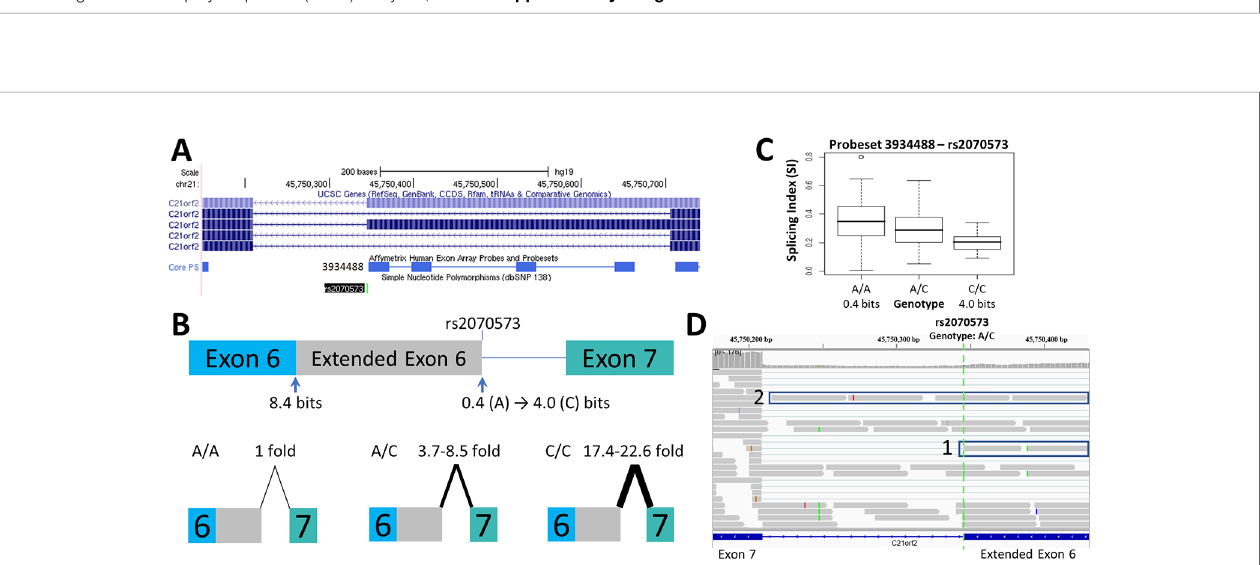
FIGURE 2 | Splicing Impact of rs2070573 ( C21orf2 ). (A) The single nucleotide polymorphisms (SNP) rs2070573 is a common polymorphism which alters the fi rst nucleotide of the extended form of C21orf2 exon 6. (B) The donor site is strengthened by the presence of the C-allele ( R i 0.4 to 4.0 bits; A > C) and its use extends the exon by 360 nt. Q-RT-PCR found a ~4-9-fold and ~17-23-fold increase in the extended exon 6 splice form in the A/C and C/C cell lines tested, respectively. (C) The exon microarray probeset which detects the extension (ID 3934488) shows a stepwise increase in SI with C-allele individuals which supports the q-RT-PCR result . (D) The variant was present in ValidSpliceMut, which associated the A-allele with an increase in total intron retention [six patients fl agged for total intron retention read abundance; p=0.019 (average over all patients)]. This image displays sequence read distributions in the RNAseq data of TCGA BRCA patient, TCGA- BH-A0H0, who is heterozygous for rs2070573. The IGV panel indicates reads corresponding to total intron 6 retention [Box 1] and which extend beyond the constitutive donor splice site of exon 6 into the adjacent intron [Box 2]. All 4 reads which extend over the exon splice junction are derived from the G-allele (strong binding site; not all visible in panel D ).